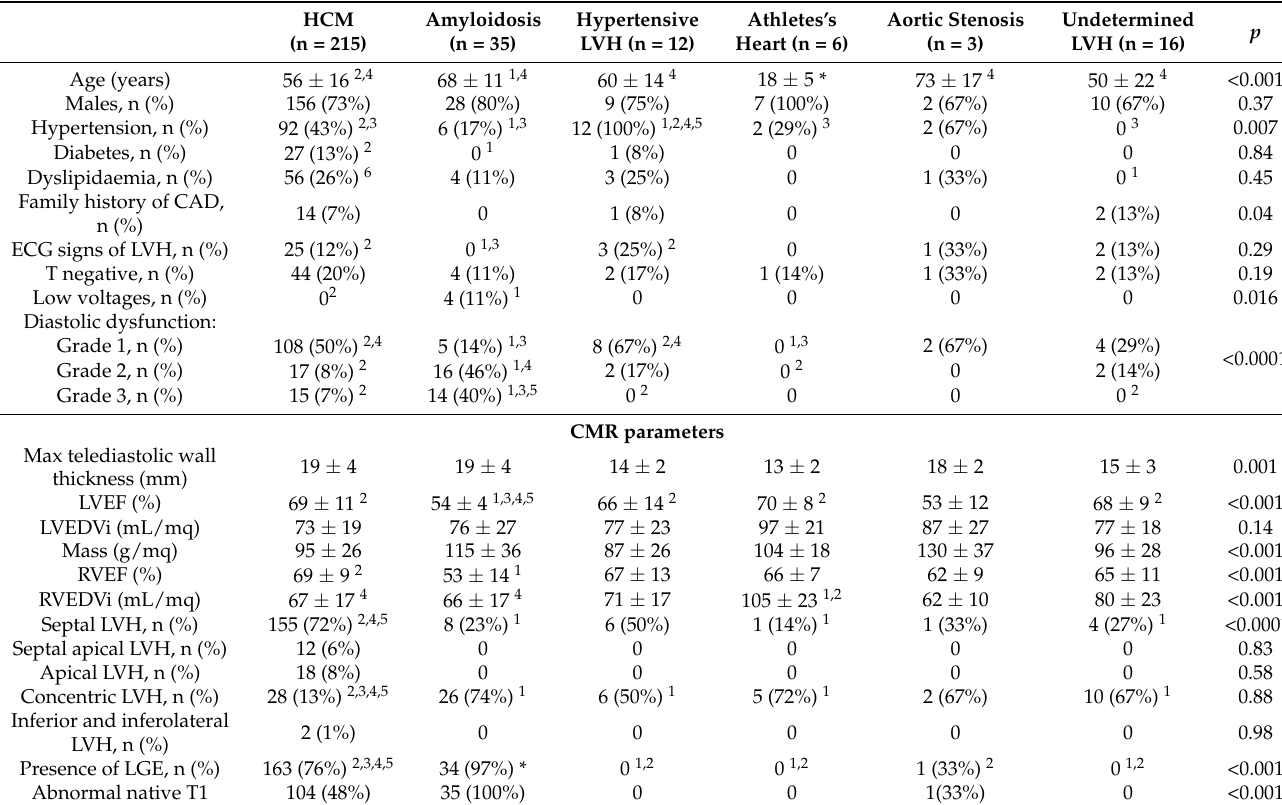
Table 3. Comparison of patient groups based on CMR